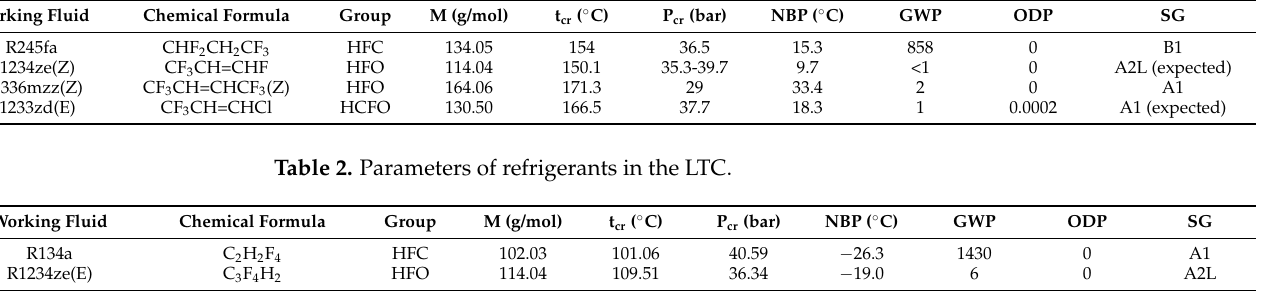
Table 1. Parameters of refrigerants in the HTC.